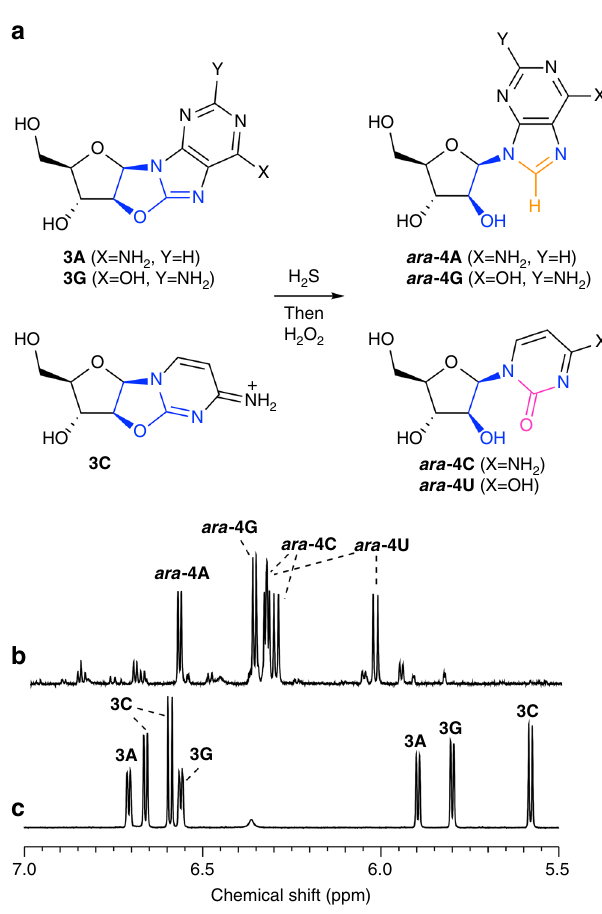
Fig. 5 Concomitant synthesis of four Watson – Crick base-pairing nucleosides. a One-pot reaction of an equimolar mixture of anhydroadenosine ( 3A ), anhydroguanosine ( 3G ) and anhydrocytidine ( 3C ) with H 2 S (20 equiv., pH 7) in water, then H 2 O 2 (20 equiv., pH 7) in water affords adenosine ara -4A (53%), guanosine ara -4G (62%), cytidine ara - 4C (47%) and uridine ara -4U (35%). The isourea moieties (blue) of the anhydropurines ( 3A/G ) and anhydropyrimidine ( 3C ) were differentiated in situ to afford the canonical Watson – Crick base-pairing nucleobase moieties regiospeci fi cally on a furanosyl-sugar scaffold, by reduction (orange) and hydrolysis (magenta), respectively. b 1 H NMR spectrum (600 MHz, 9:1 H 2 O/D 2 O, 25 °C, δ = 5.5 – 7.0 ppm) showing the prebiotic synthesis of cytidine ara -4C , uridine ara -4U , adenosine ara -4A